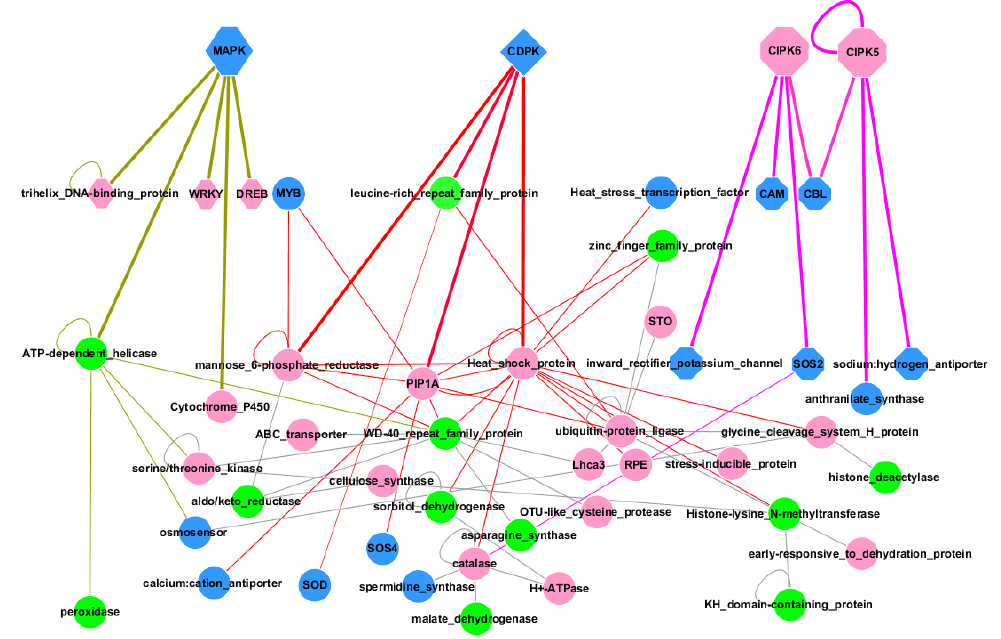
Figure 3. Interaction network of salt-responsive genes in Malus zumi . The interactions of salt responsive genes were predicted by their homologs in Arabidopsis. A total of 22 up-regulated genes ( red ), 12 down-regulated genes ( green ) in microarray, and 15 potentially interactive proteins ( blue ), were presented in the interaction network. CDPK appeared as quadrilateral, lines between CDPK and its interactive proteins were magenta; MAPK appeared in hexagon, lines between MAPK and its interactive proteins were khaki; CIPKs appeared in octagon, lines between CIPKs and its interactive proteins were red. The thick lines represented the direct interaction with kinases, the thin lines represented the interaction between proteins. Details of gene information were listed in Supplementary file (Table